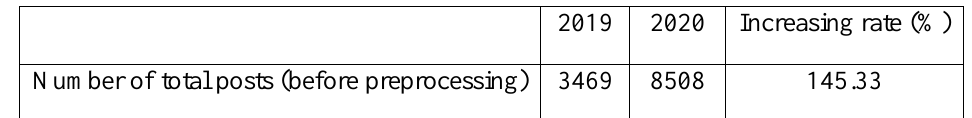
Table 3 Instagram posts datasets